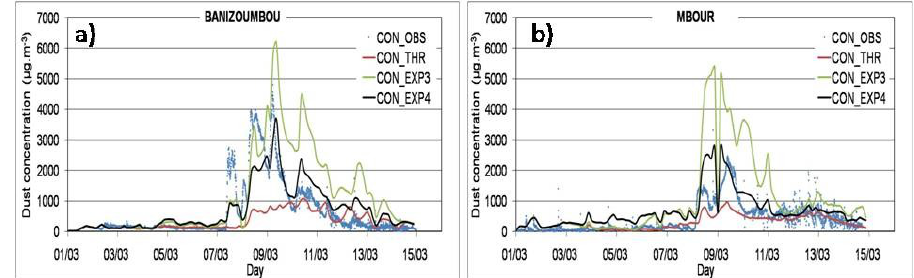
Fig. 15. Evolution of the dust surface concentration in ( µ gm − 3 ) simulated by ALADIN, with three dust emission configurations: THR (red line), EXP3 (green line) and EXP4 (black line), between 1 and 15 March 2006, over (a) Banizoumbou and (b) Mbour, compared with the observations.